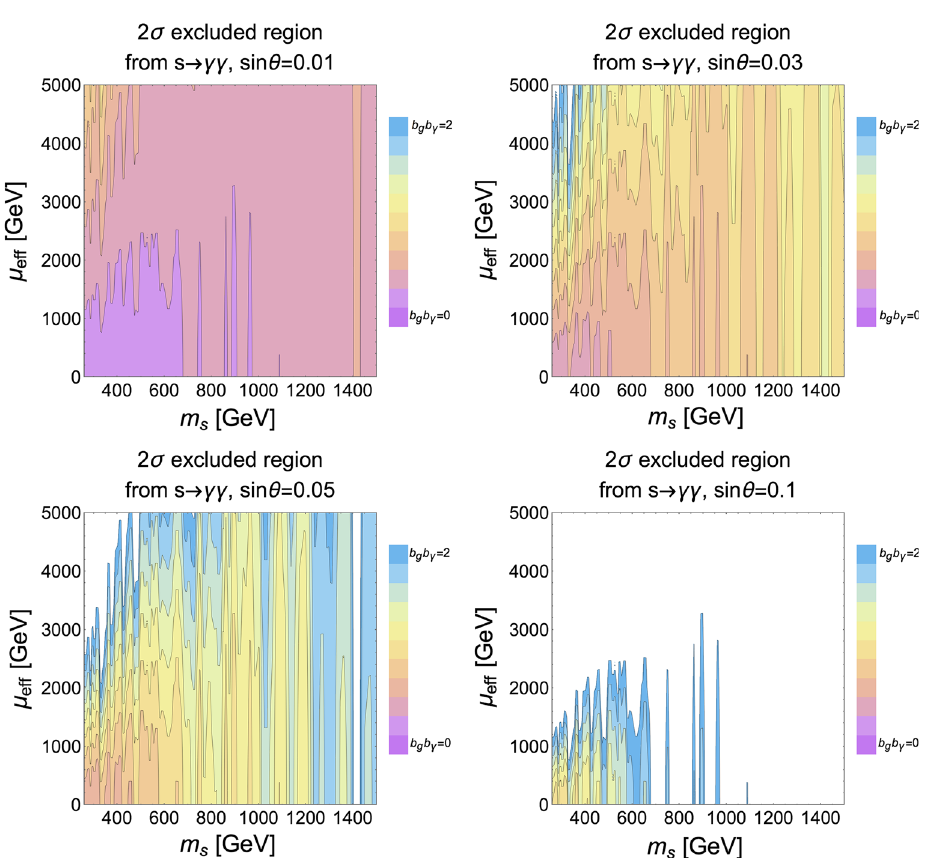
Fig. 7 The 2 σ -excluded regions from s → γγ bound in the μ eff vs. m s plane for various sin θ . The color is changed in increments of 0.2. K -factor is set to be K = 1 . 6